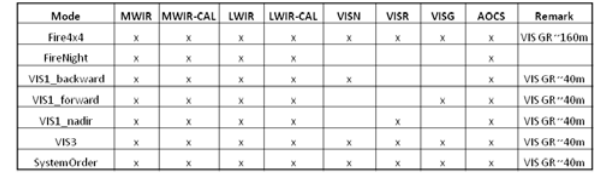
Table 2. TET-1 Standard Mode